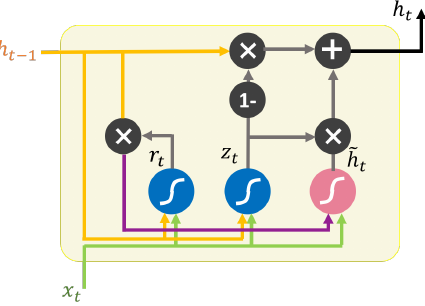
Figure 7. The structure of the Gated Recurrent Unit (GRU) cell where x t is from